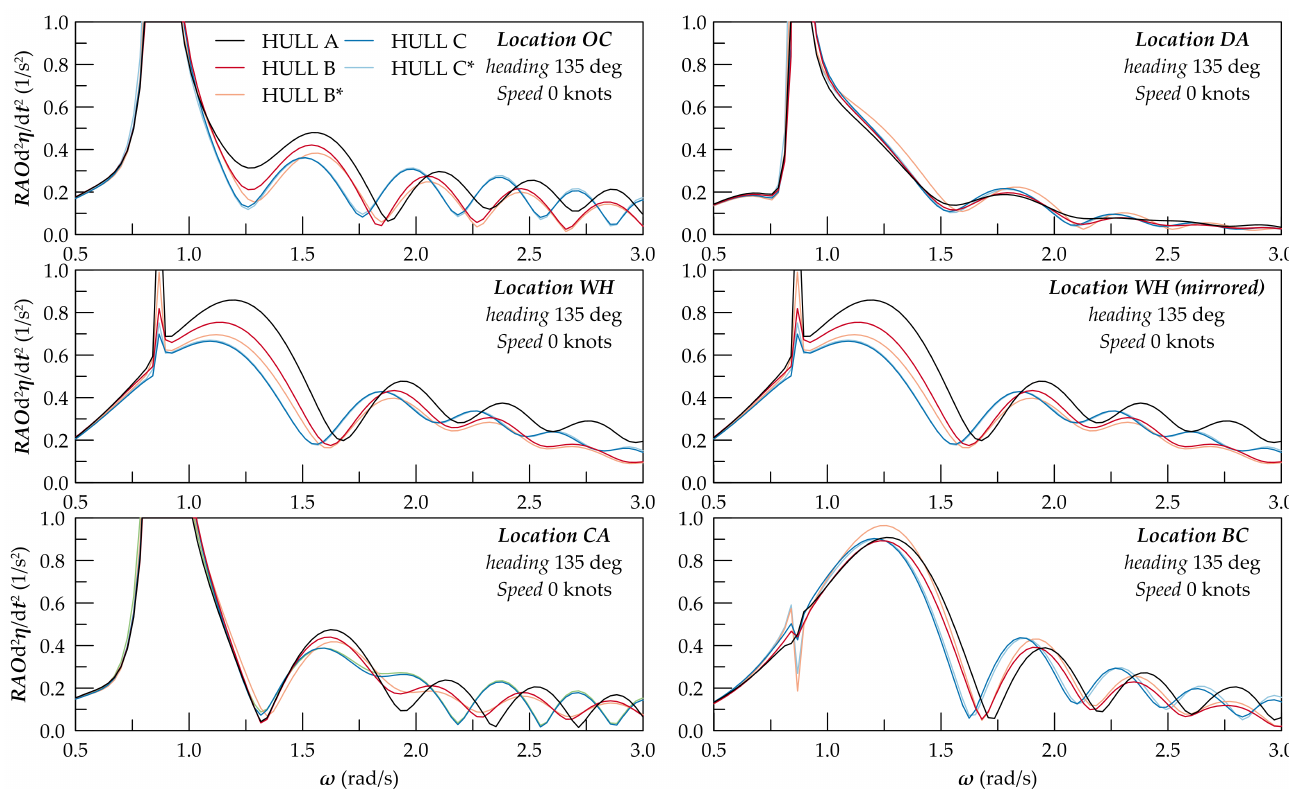
Figure 13. Absolute lateral acceleration RAO at 0 knots on the reference hulls for the AWI